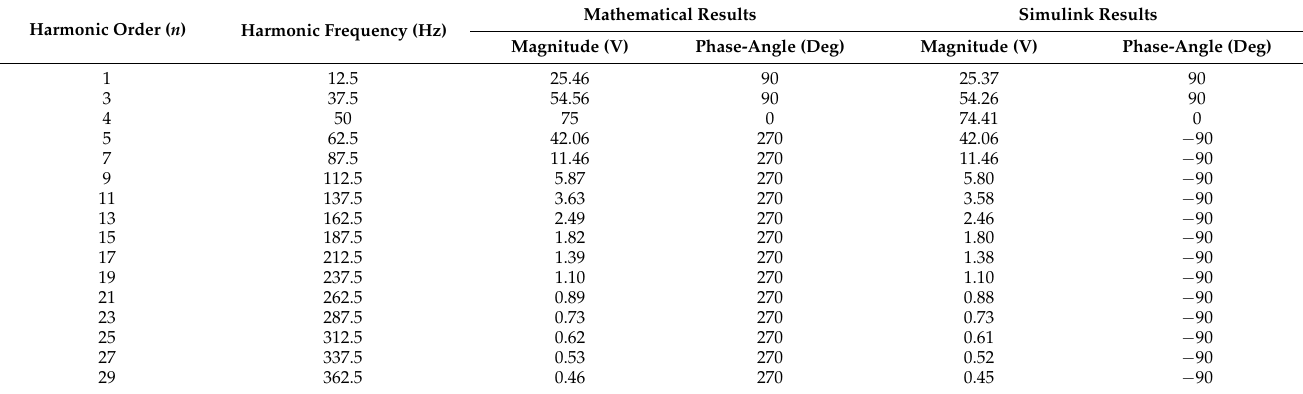
Table 4. Harmonic coefficients of output voltage control with on-off cycle